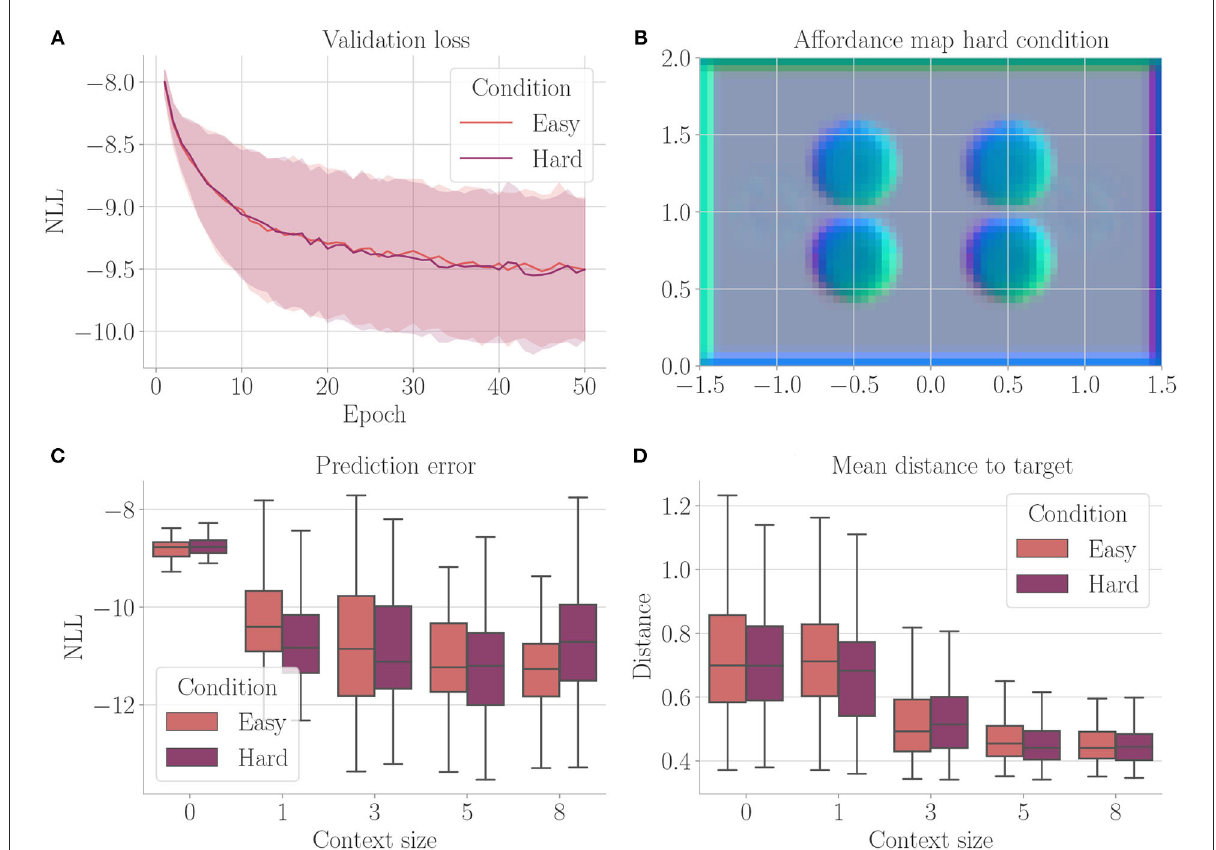
FIGURE9 Results from Experiment III–Behavioral-relevance of affordance codes (Section 4.5). For each setting, the results are aggregated over 25 differently initialized models which each performed 4 goal-directed control runs for 200 time steps. The box plots show the medians (horizontal bars), quartiles (boxes), and minima and maxima (whiskers). Data points outside of the range defined by extending the quartiles by 1.5 times the interquartile range in both directions are ignored. “Easy” refers to the environment from Experiment I, “hard” refers to the condition with upper and lower obstacles encoded differently and additional meaningless information. (A) Validation loss during training. It is the negative log-likelihood of the actual change in position in the transition model’s predicted probability distribution. Shaded areas represent SDs.